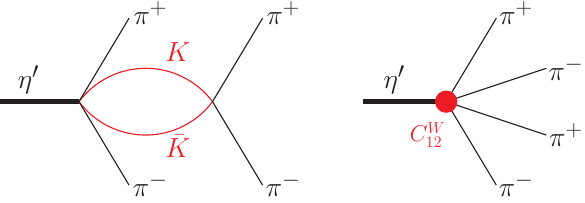
Fig. 1. Feynman diagrams contributing to η ′ → 2( π + π − ) at leading order, O ( p 6 ). Left: The η ′ π + π − K ¯ K vertex (to the left of kaon loop) denotes a pentangle anomaly coupling of O ( p 4 ), the KK → ππ scattering (to the right of kaon loop) is of O ( p 2 ). Right: ( C W ) vertex from the O ( p 6 ) anomalous counter-term Lagrangian of [9]. The 12 η ′ → π + π − 2 π 0 amplitude is described by analogous amplitudes.